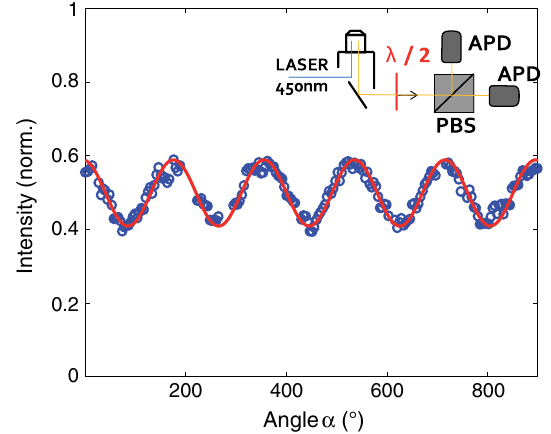
FIG. 6. Circles: Dependence of detected intensity as a function of the polarization analysis angle for a nanocrystal of CdSe/CdS in the vicinity of an air-dielectric interface. This curve is normalized by the total intensity detected on both photodiodes in order to account for fluctuations of the total emitted intensity. The different detection efficiencies of the two paths are corrected so that the normalized curve has a mean value of 0.5. The fitted curve (solid red line) corresponds to Eq. (26). From the fit, we deduce that Θ ¼ 44 ° and Φ ¼ 52 °.